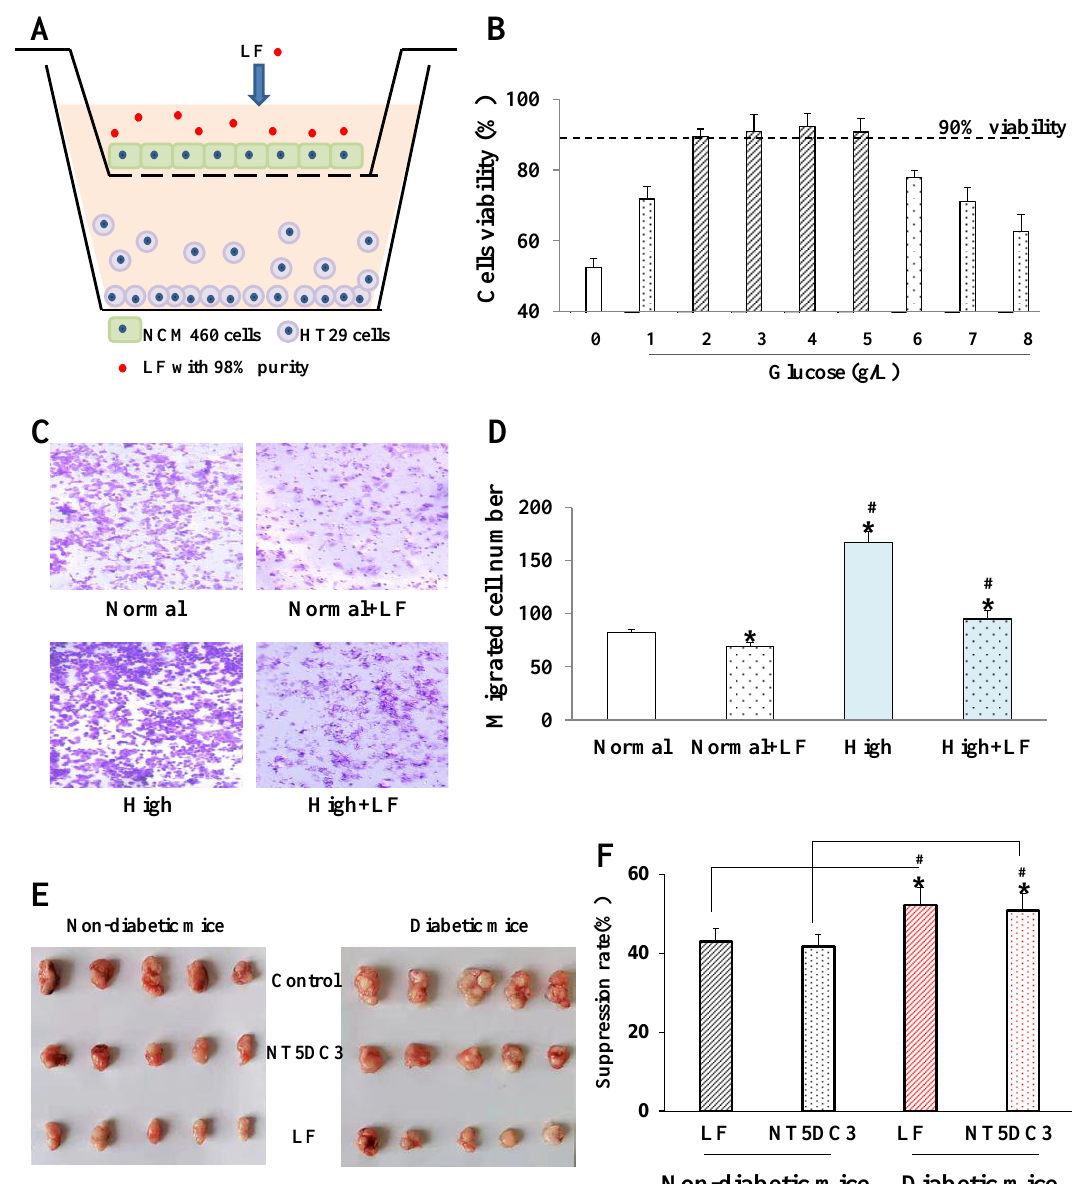
Figure 1. The anti-tumor effect of lactoferrin (LF) and NT5DC3 in high glucose conditions. ( A ) Co-culturing model consisting of NCM460 cells and HT29 cells. HT29 cell growth culture medium was further utilized to cultivate the NCM460 cells. ( B ) Glucose concentration selection using the NCM460 cells and a cell viability assay. Here, 2–5 g/L of glucose was regarded as the appropriate concentration for subsequent experiments. ( C ) Invasion ability assay of NCM460 cells in the presence of different glucose concentrations, using Transwell (200 × ). ( D ) Number of migrated cells in ( C ). ( E ) Tumors in the different non-diabetic and diabetic mouse groups. ( F ) Suppression rate in each group in (E). The data are presented as mean ± SD, * p < 0.05 compared with the LF or Non-diabetic NT5DC3 group, # p < 0.05 compared with the normal group in ( D ), # p < 0.05 compared with the normal group in ( F ). ( A – D ) the experiments were repeated three times ( n = 3); ( E , F ) the experiments were repeated five times ( n =